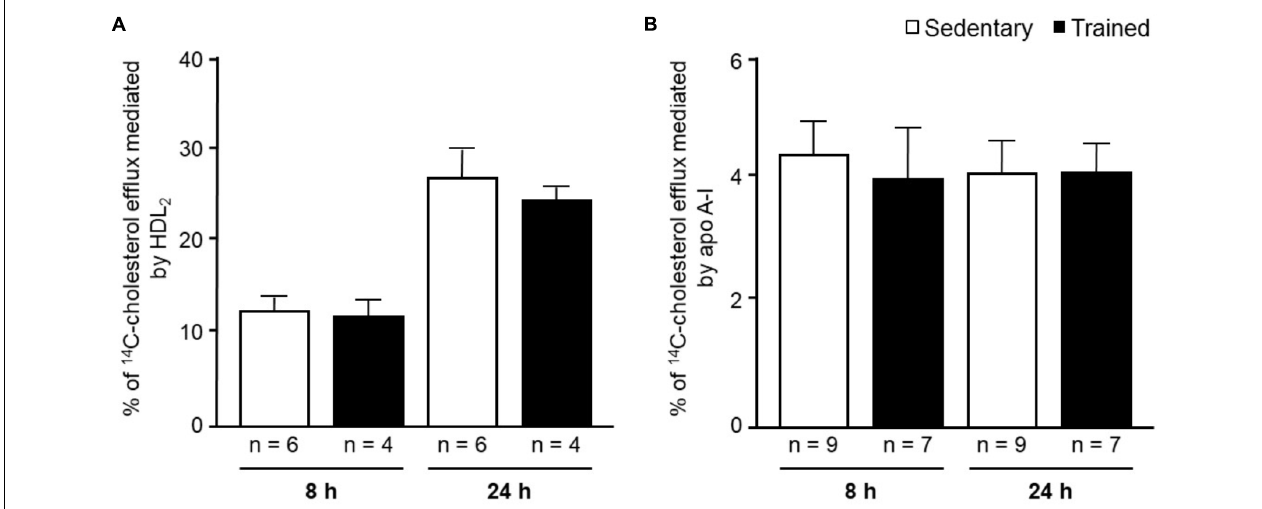
FIGURE 6 | 14 C-cholesterol efflux from peritoneal macrophages harvested from sedentary (S) and trained (T) 48 h after the last exercise session. Macrophages were isolated from the peritoneal cavity of CETP-tg S ( n = 9) and T ( n = 7) mice 48 h after the last session of exercise. Cells were overloaded with acetylated LDL (50 µ g/mL) and 14 C-cholesterol (0.3 µ Ci/mL) and, after incubation with equilibrium media, were exposed to HDL 2 (A) or apo A-I (B) for 8 h and 24 h. The % cholesterol efflux was determined as: 14 C-cholesterol in media/ 14 C-cholesterol in media + 14 C-cholesterol remaining in cells x 100. Comparisons were done by the unpaired Student t -test (mean ±